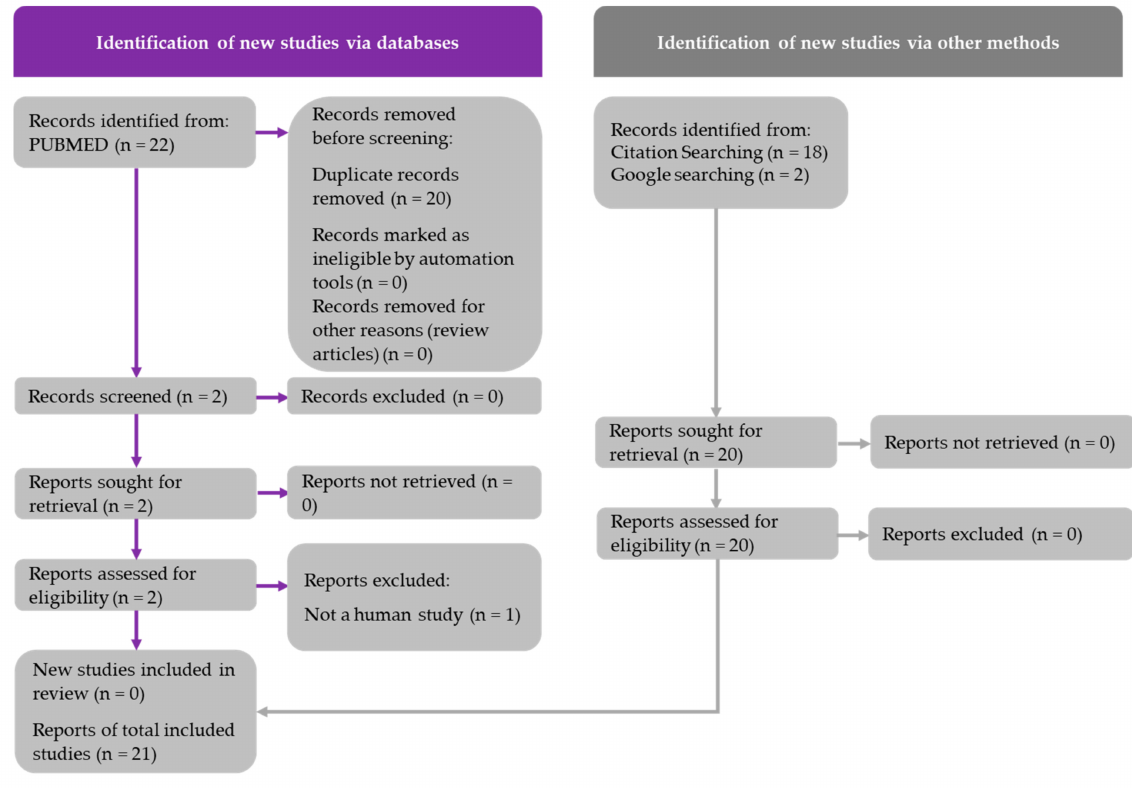
Figure 2. PRISMA flow chart for human studies indicating how the 21 studies were